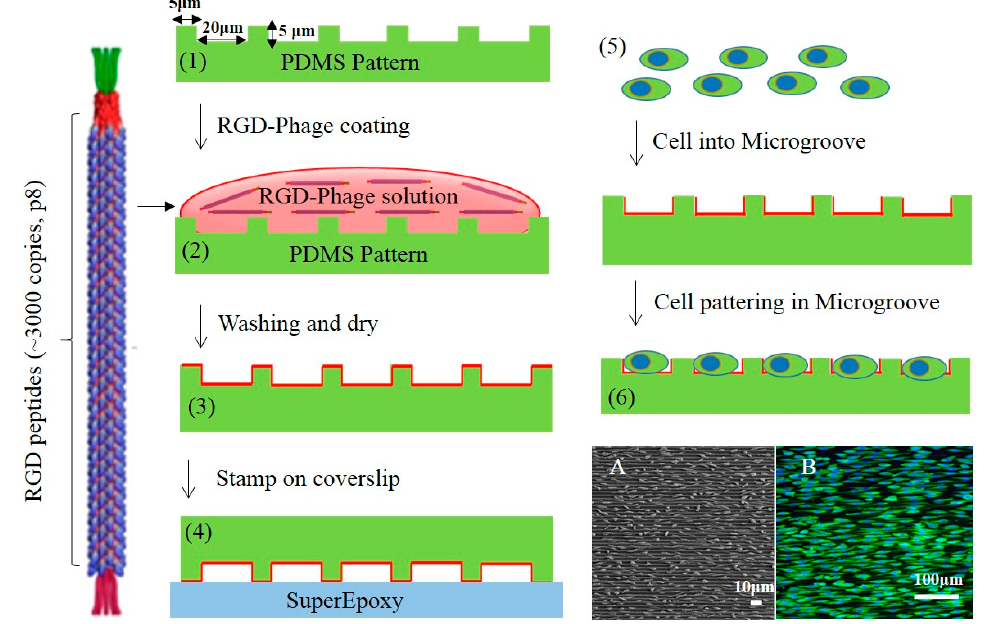
Figure 1. Schematic illustration of the fabrication method for RGD-Phage coating on 1D micro-patterned PDMS. Fluorescence and SEM ( A ) and Fluorescence images ( B ) of cell patterning in microgrooves.